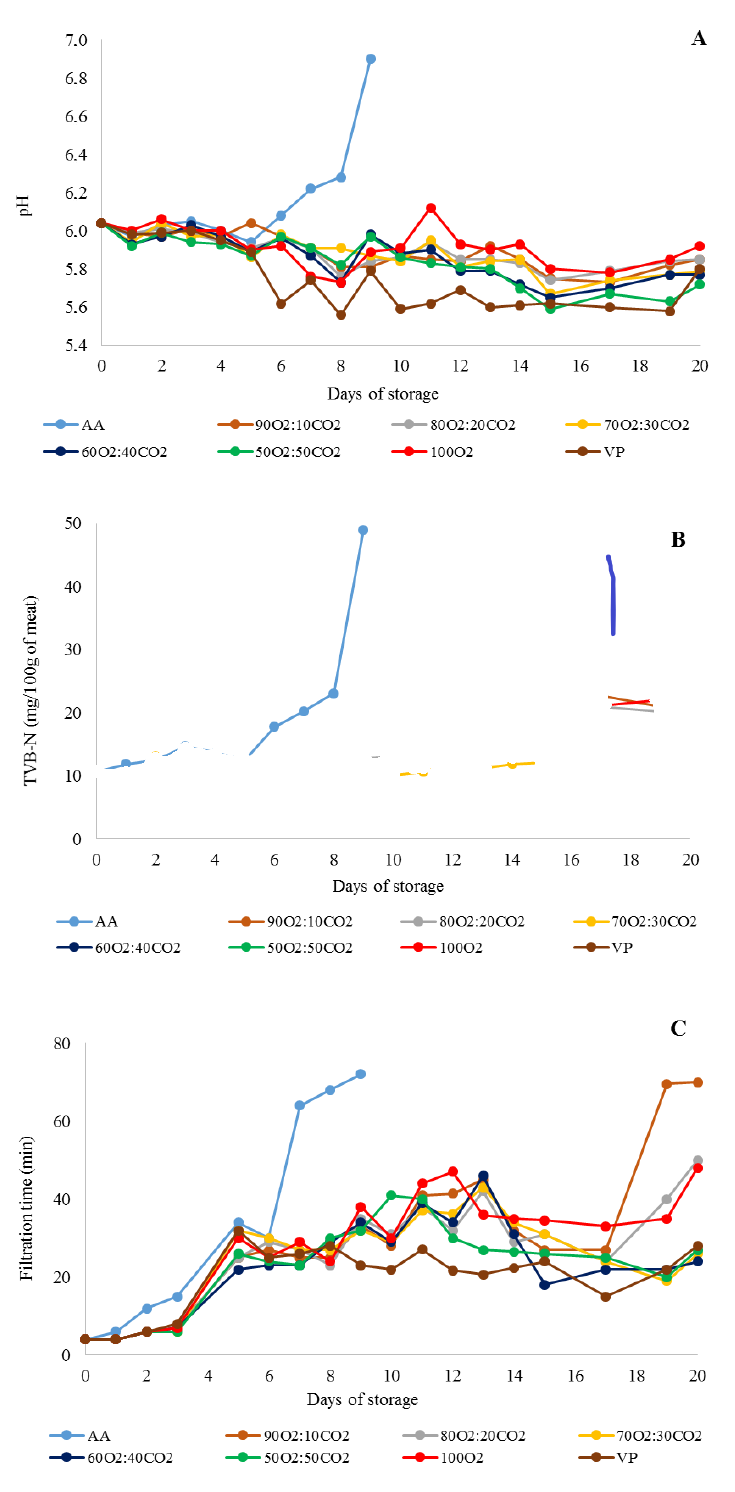
Figure 2. Results of pH: ( A ) total volatile basic nitrogen (mg of TVB-N / 100 g of meat); ( B ) and filtration time (min); ( C ) of the ground beef treated with di ff erent packaging systems stored at 2 ◦ C for 20 days. AA (ambient air); 90O 2 :10CO 2 , 80O 2 :20CO 2 , 70O 2 :30CO 2 , 60O 2 :40CO 2 , 50O 2 :50CO 2 , and 100O 2 (modified atmosphere packaging with 90%:10%, 80%:20%, 70%:30%, 60%:40%, 50%:50%, and 100%:0% of oxygen and dioxide carbon ratios, respectively); VP (vacuum packaging).